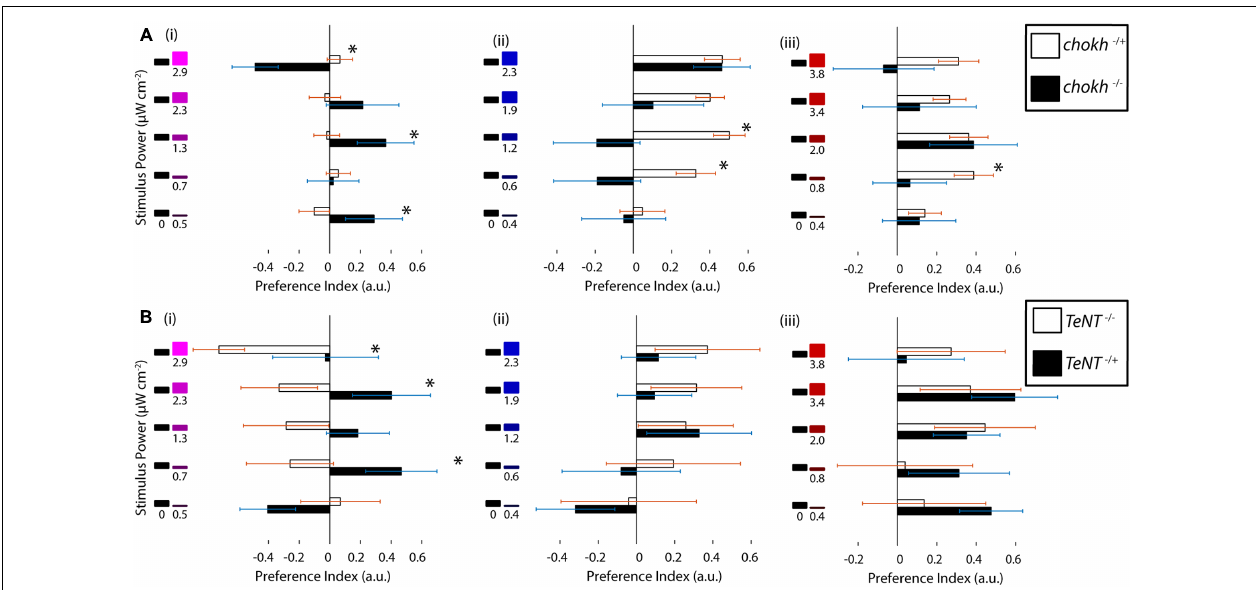
FIGURE 3 | Ultraviolet avoidance is mediated by a visual process, and it depends on the presence of functional UV cones. (A) Preferences of eyeless chokh mutant fish and their wildtype siblings for the UV, blue and red stimuli vs. darkness. White bars show the wild type animal results and black bars the blind mutant results ( N = 18). (B) Preferences of sws1 ::TeNT-CFP transgenic fish with inactive UV cones vs. their wildtype siblings. The stimuli consisted of darkness vs. varying intensities of the UV, blue or red stimuli as in part A and Figure 1 . The white bars show the wild type fish results and the black bars show the transgenic animal results ( N = 8, bars in both experiments are mean ± SEM with animals from different clutches. Stars represent a p -value < 0.05 in an unpaired t -test comparing the two